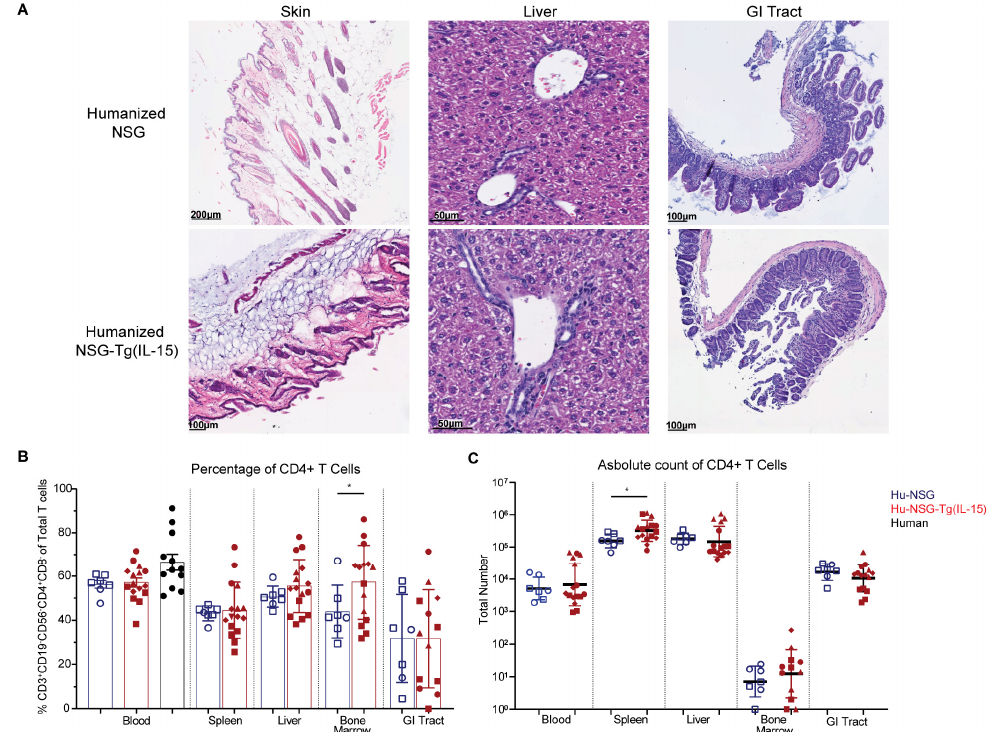
Figure 2. Humanized NSG ‐ Tg(IL ‐ 15) mice do not develop signs of GVHD . ( A ) H&E staining of FFPE skin, liver, and GI from Hu ‐ NSG and Hu ‐ NSG ‐ Tg(IL ‐ 15) mouse 6–9 months post ‐ transplant with CD34 + stem cells. ( B ) Percentage of human CD4 + T cells (CD19 ‐ CD56 ‐ CD3 + CD4 + CD8 ‐ ) in PBMC, spleen, liver, bone marrow, and gastrointestinal tract in Hu ‐ NSG ( n = 7, 2 unrelated donors) and Hu ‐ NSG ‐ Tg(IL ‐ 15) ( n = 16, 4 unrelated donors). ( C ) Total number of human CD4 + T cells in PBMC, spleen, liver, bone marrow, and gastrointestinal tract. Mice reconstituted from unrelated human donor cord ‐ blood ‐ derived CD34 + stem cells are denoted by different symbols. Statistical significance was calculated using an unpaired t ‐ test for 2 groups or Brown–Forsythe test with Dunnett’s test for multiple comparisons for 3 groups. * p < 0.05.